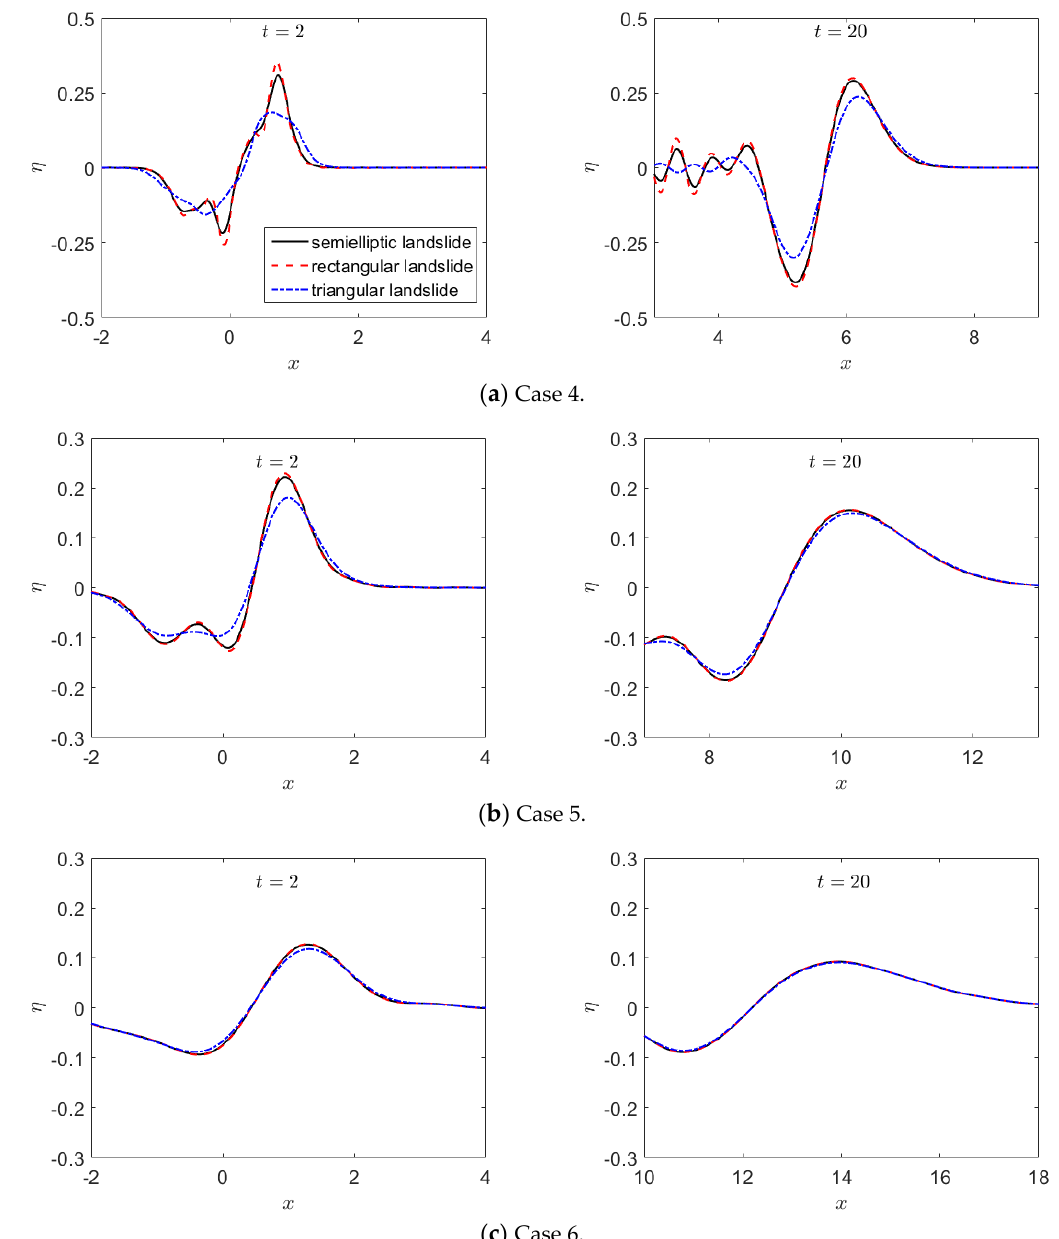
Figure 6. Comparisons of water waves generated by landslides with three different shapes (Fr = 0.375, linear weakly dispersive (LWD) model).